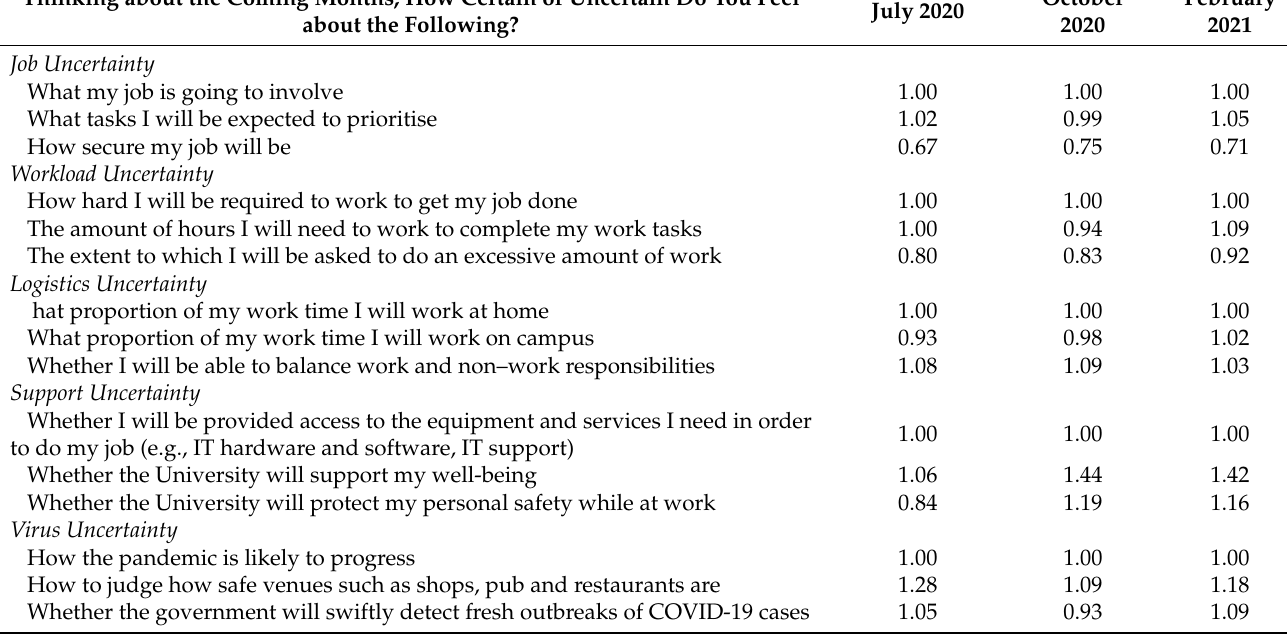
Table 1. The new uncertainty scale with unstandardised factor loadings for the different study